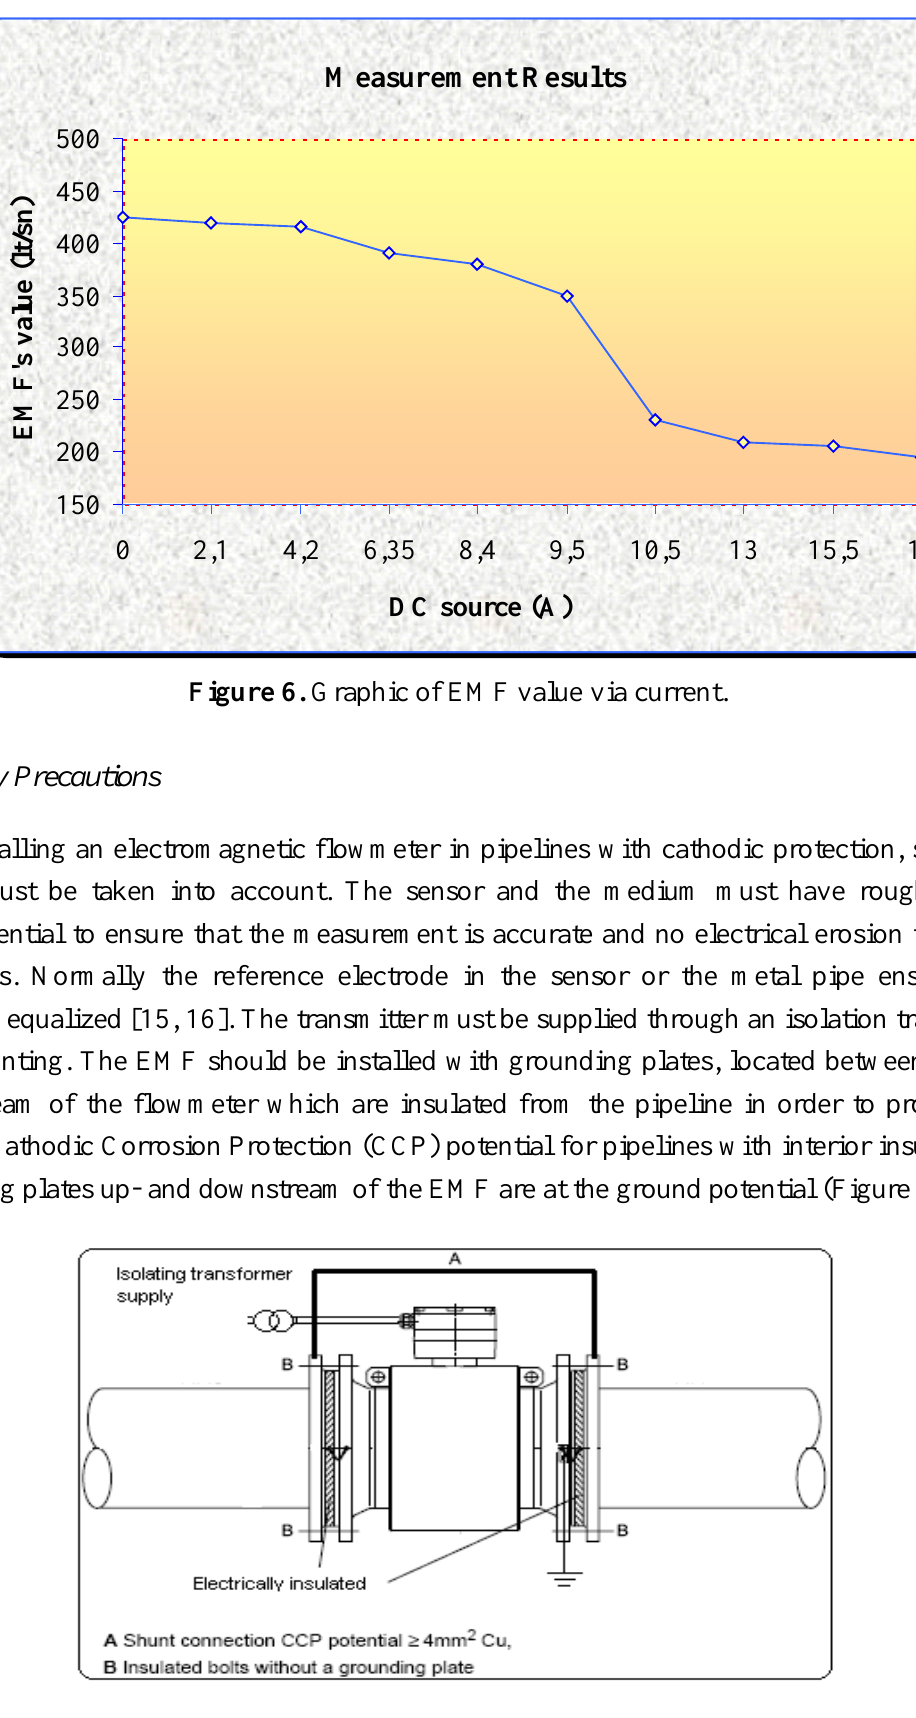
Figure 7. Flowmeter with grounding plates and